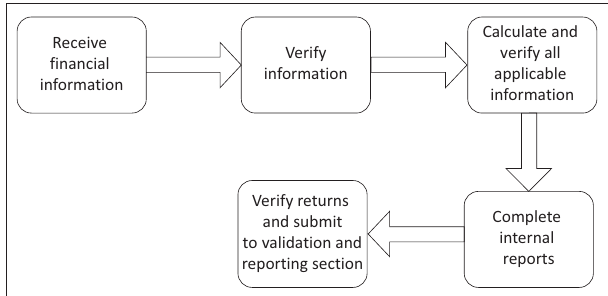
FIG URE 14: Workflow of economic capital management.